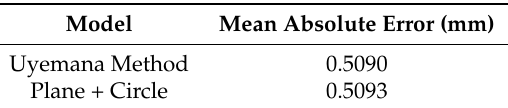
Table 5. Model errors.